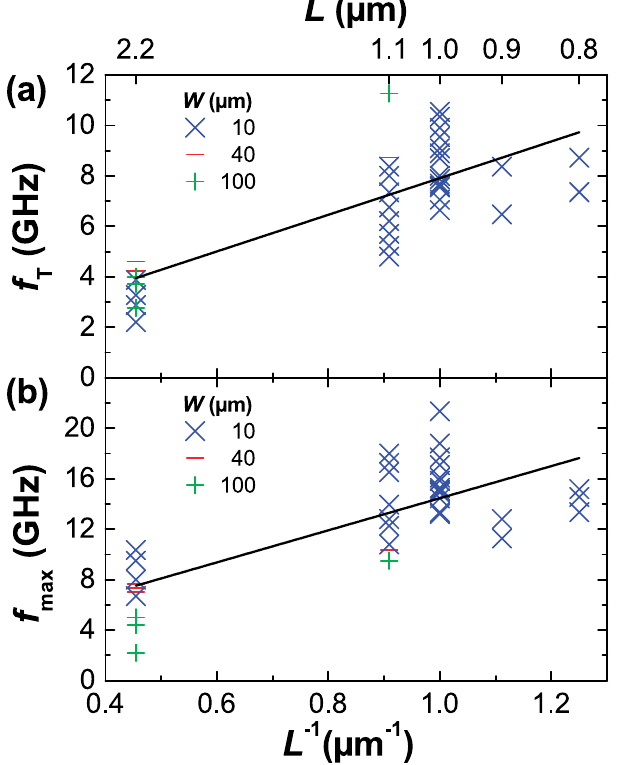
Figure 4. The largest values of the high-frequency transistor response parameters of each fabricated GFET as a function of gate length L . ( a ) The cuttof frequency f suggested by the black line in both